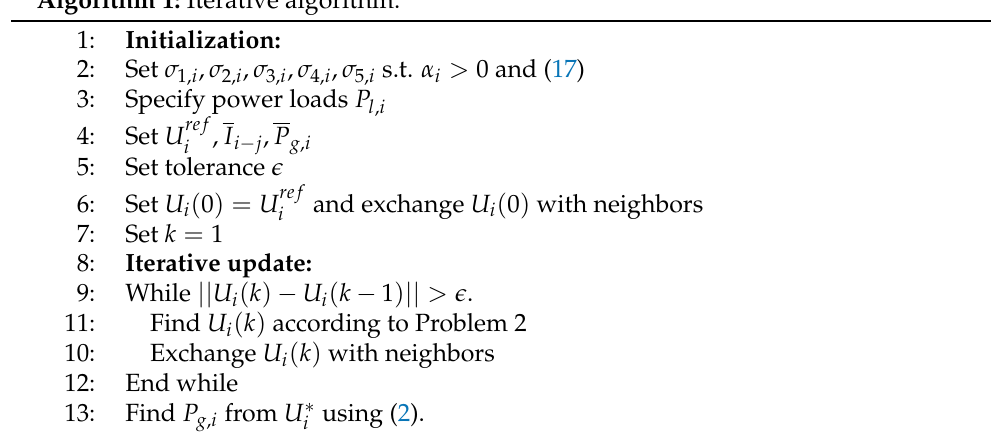
Algorithm 1: Iterative